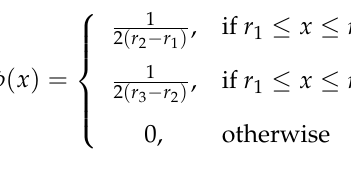
Figure 2. Schematic diagram of expected additional gas shortage and emission. 4. Model Establishment for Byproduct Gas Scheduling 4.1. Fuzzy Variables in Byproduct Gas System One of the main characters of the fuzzy approach is that uncertain parameters can be expressed by fuzzy variables. In our work, triangle membership function is applied to express the generation